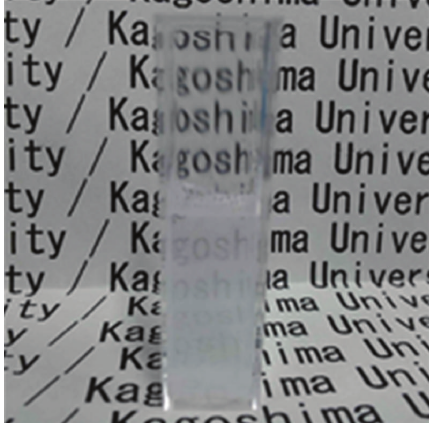
Figure 7: A photograph of aqueous suspension (1.0 w/v%) of the product obtained by ion-exchange reaction of the SQ/ZrO 2 -NP (feed molar ratio of APTMOS/ZTB = 0.3) with sodium laurate.